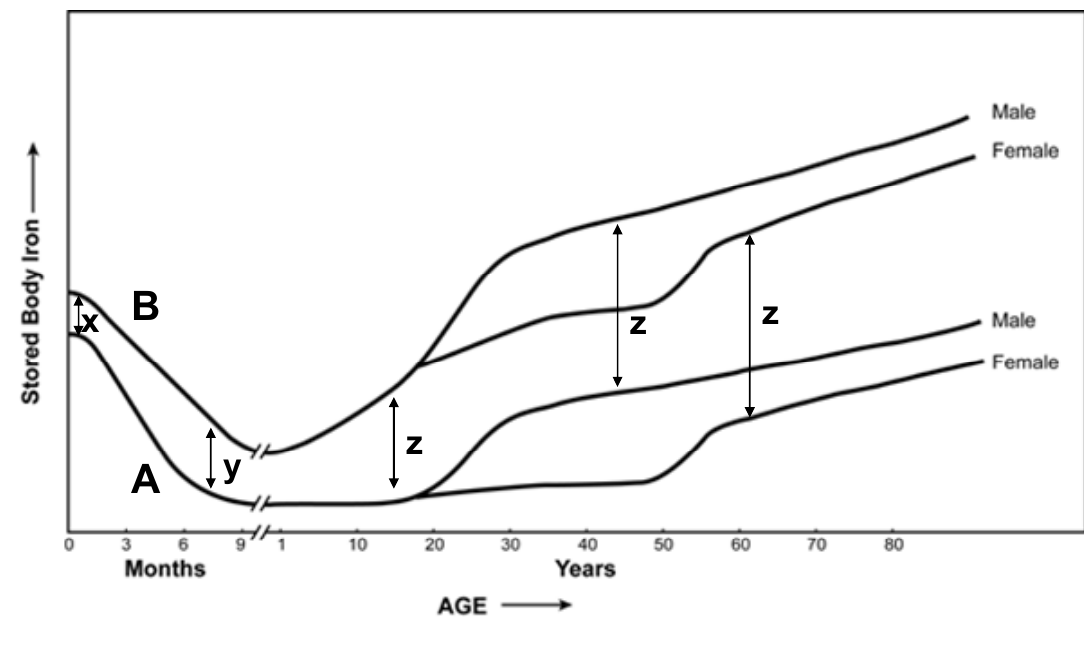
Figure 1. Stored iron in the human. Tracings A and B are proposed to represent stored iron in the human prior to and after, respectively, recent interventions in